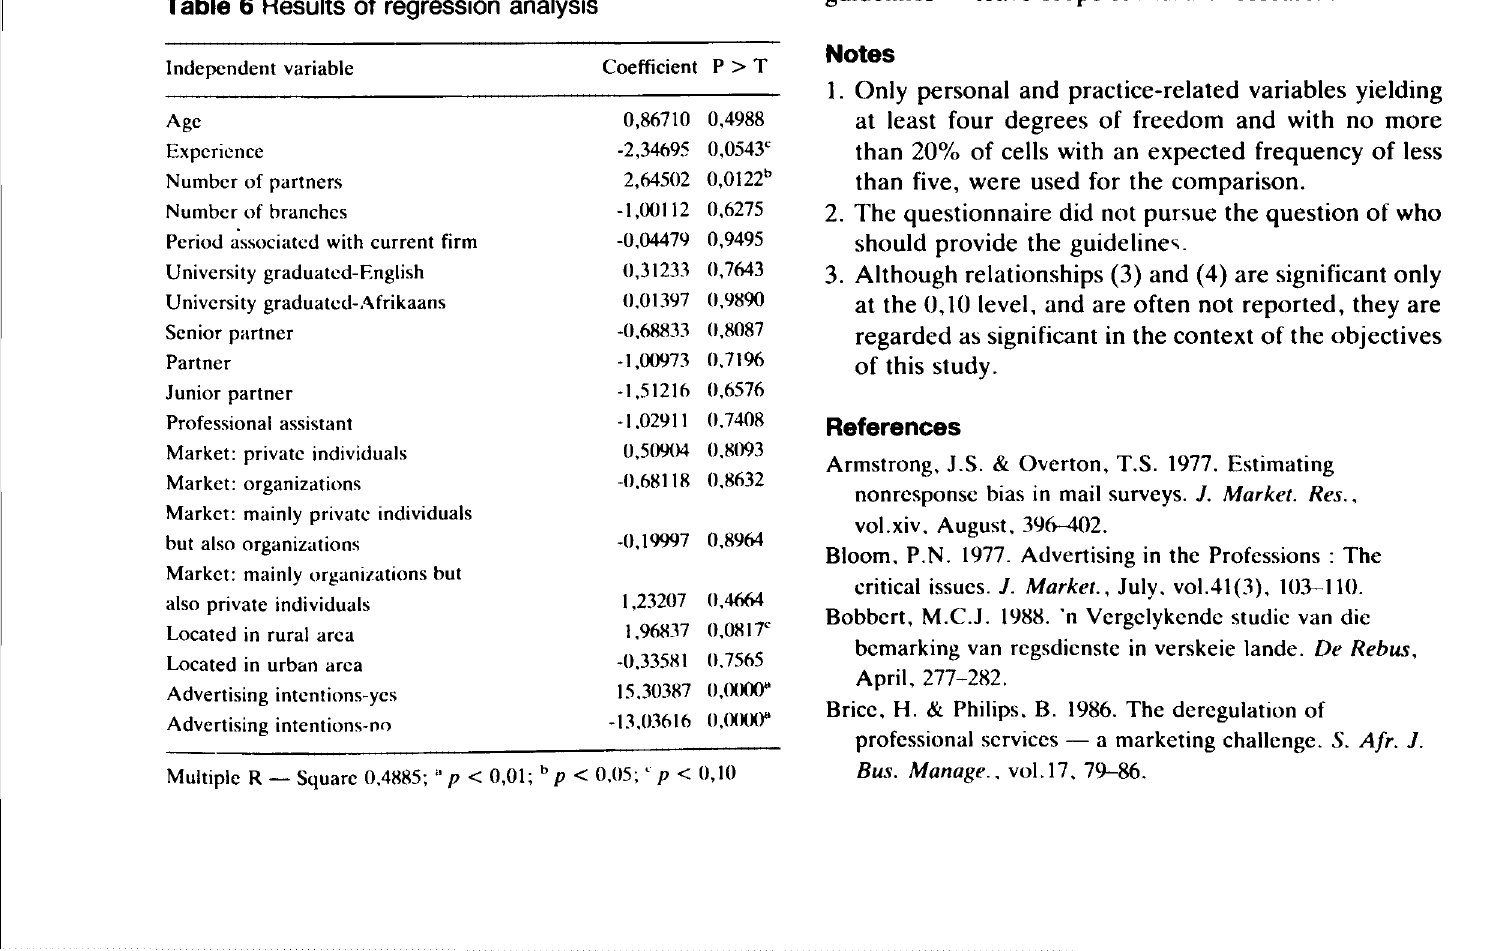
Table 6 Results of regression